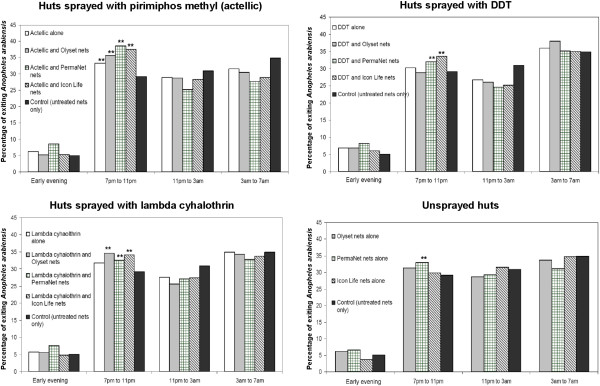
Effects of IRS/LLIN applications on the time when Anopheles arabiensis exited volunteer-occupied experimental huts during the wet season tests. Bars marked with two stars (**) denote irritant applications that caused significantly more mosquitoes (P < 0.05) to exit earlier than in the controls.